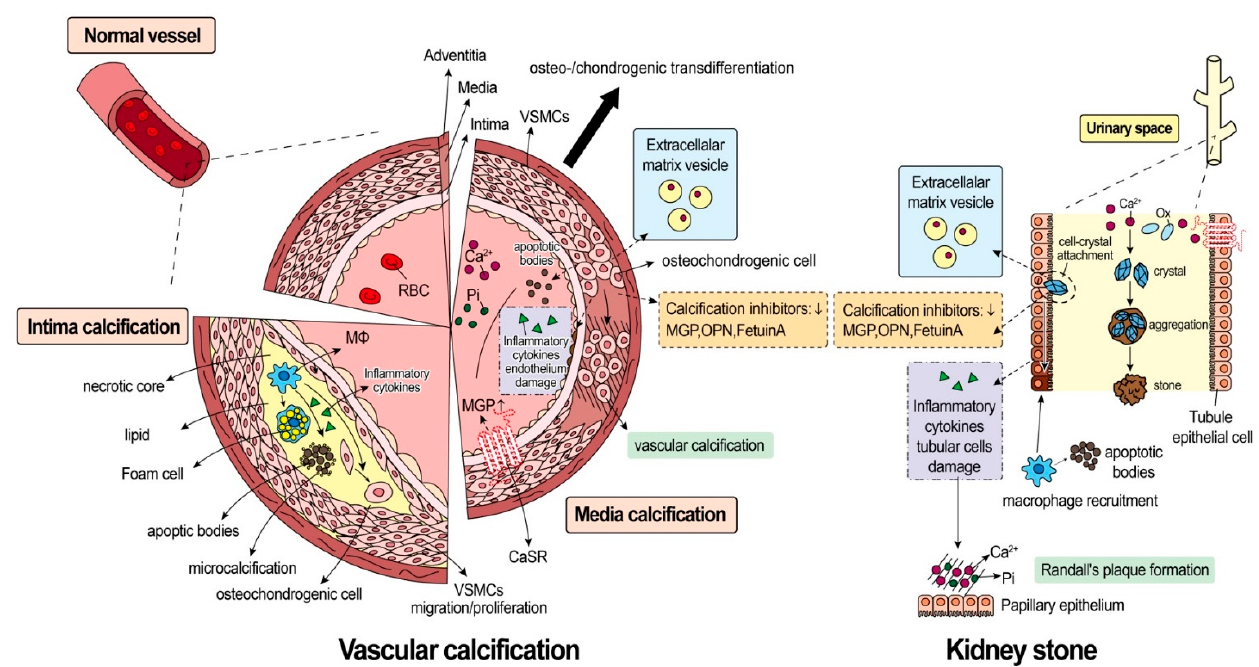
Figure 2. Crosstalk between vascular calcification and nephrolithiasis. The process of vascular calcification is demonstrated on the right while that of kidney stone formation is depicted on the left. The molecular characteristics shared by these two distinct diseases are highlighted by the same-colored block. Vascular calcification can be categorized into intimal calcification and media calcification. 1. Intimal calcification is frequently associated with atherosclerosis. Macrophage (M φ ) digests lipoproteins and converts them to cholesterol-rich foam cells. Initially, foam cells can be phagocyted by adjacent vascular smooth muscle cells (VSMCs) and release apoptotic bodies. In addition to an increase in the number of apoptotic bodies, there is an accumulation of apoptotic body debris, which results in the formation of a necrotic core. Vesicles in the necrotic core release microcalcification of calcium phosphate as nucleation nidus. 2. Medial calcification is largely related to osteo-/chondrogenic transdifferentiation, which indicates the change in phenotype of VSMCs into osteo-/chondroblasts like cells. Transdifferentiation can be induced by high phosphate (Pi) or calcium (Ca 2+ ) levels. The osteo-/chondroblast-like cells actively promote media calcification by reduced activities of calcification inhibitors (e.g., matrix Gla protein (MGP), osteopontin (OPN), and fetuin A), apoptotic body release, calcifying extracellular matrix vesicle release, and inflammatory cytokine release. The activation of CaSR on VSMCs can stimulate MGP release, which can ameliorate vascular calcification. The mechanism of kidney stone formation remains largely unknown. However, the supersaturated urinary stone promoters, e.g., Ca 2+ and oxalate (Ox), can gradually form crystals, and aggregated crystals could interact with tubule epithelial cells and cause epithelial damage. The cell-crystal interaction could cause calcifying extracellular matrix vesicles release and inflammatory cytokines release, with the assistance of reduced activities of calcification inhibitors (e.g., MGP, OPN, and fetuin A). M φ recruitment and polarization are also found to occur in the crystal-attached areas. Finally, Ca 2+ and Pi combine to form hydroxyapatite, which is deposited on the renal papilla and referred to as Randall’s plaque.